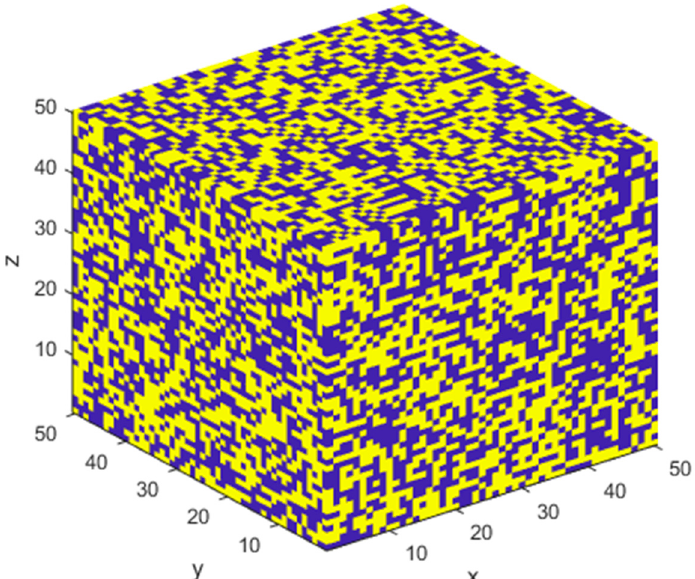
Figure 2. The model has cubic grains of two isotropic constituents (50/50 mix), randomly distributed. The boundaries of the grains are exactly aligned with the Cartesian numerical grid (50 × 50 × 50 cells), so that the contents of each cell are uniform, within that cell.